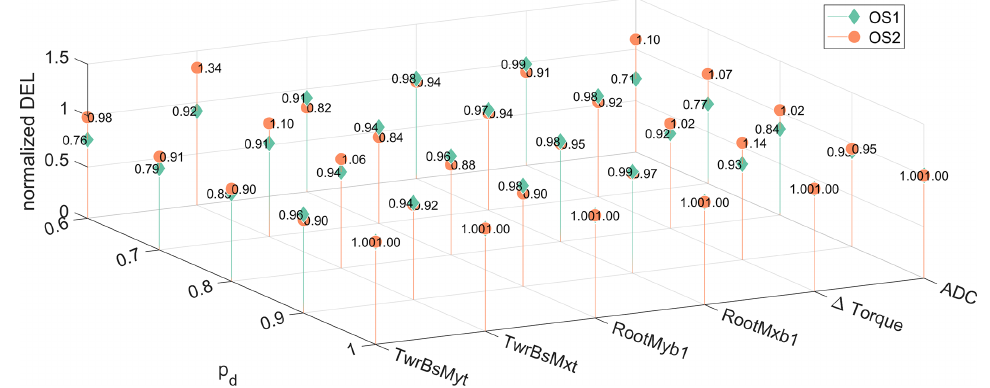
Figure 4. Comparison of damage equivalent loads (DELs) for OS1 and OS2 at different constant power tracking set points p d = { 1 , 0 . 9 , 0 . 8 , 0 . 7 , 0 . 6 } , where the data are normalized to the results of p in turbulent wind for 40min with a mean wind speed of 12ms − 1 , where the simulated wind turbine trajectories for p d = 0 . 7 are shown in Fig.